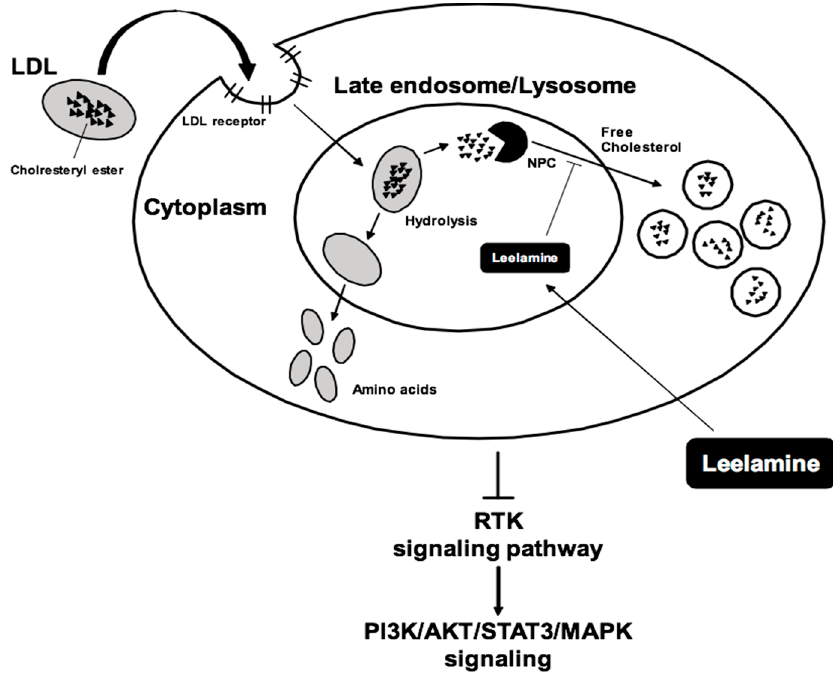
Figure 2. The potential mechanism(s) of action of leelamine. LDL: low-density lipoprotein; NPC: Nuclear Pore Complex.